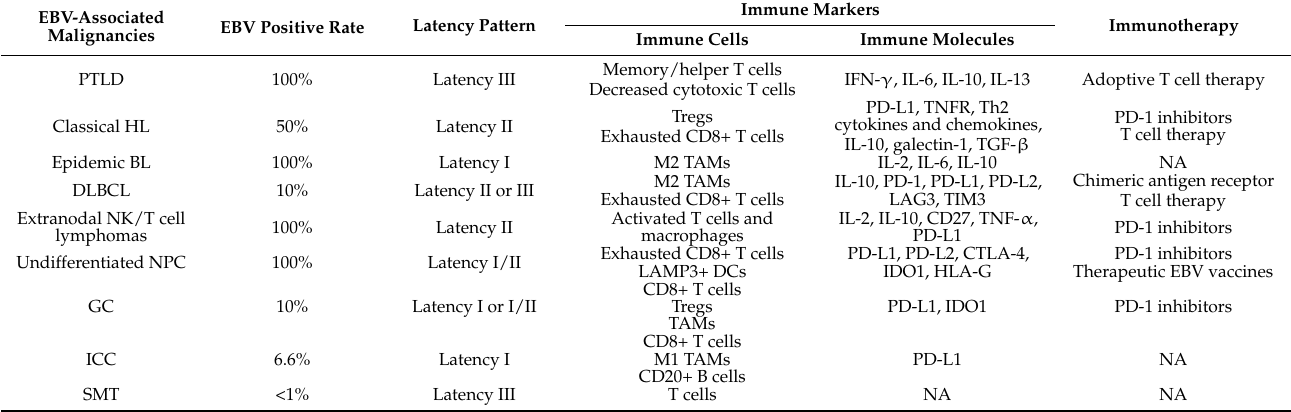
Table 1. Features of EBV-associated